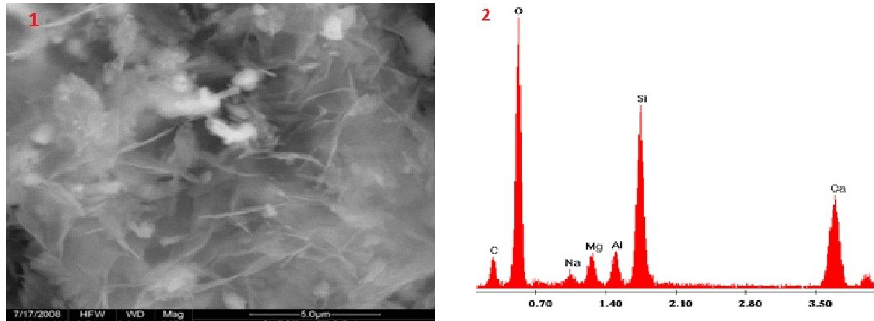
Figure 11. SEM (1) and EDX (2) of reaction product ZB4 (synthesized with 4M